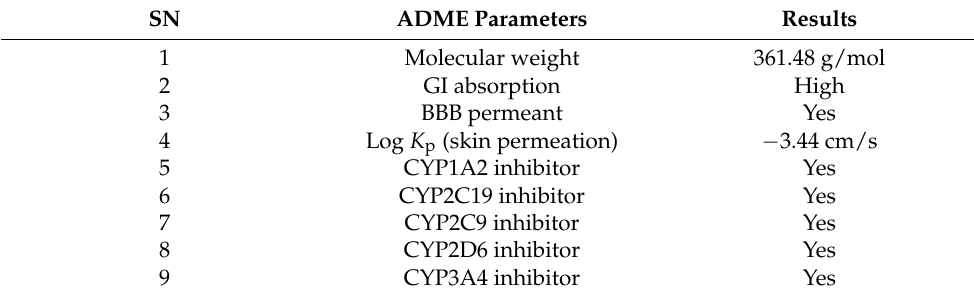
Table 4. Important ADME and QSAR tool box points of